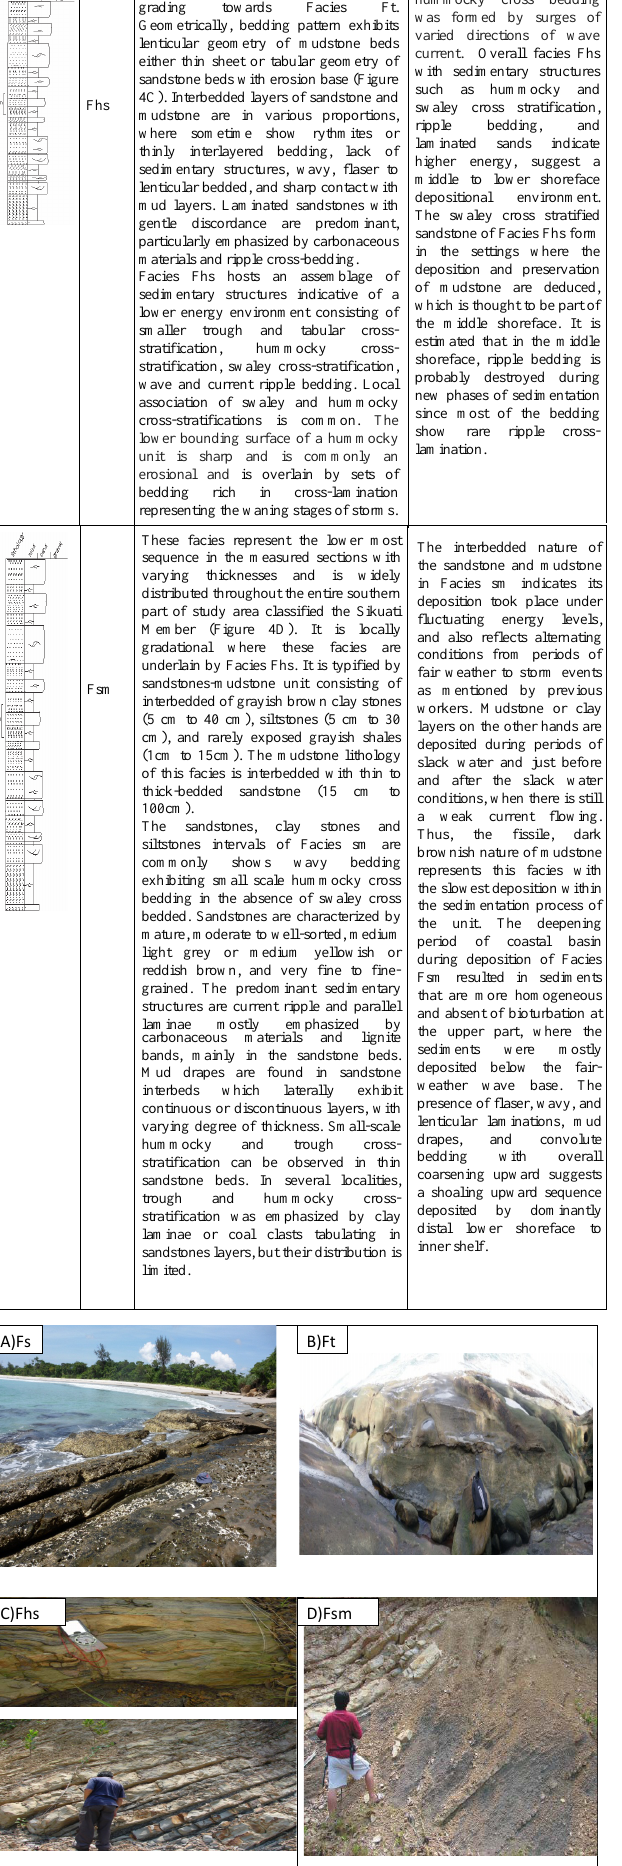
Field outcrops representing facies distribution of the study area; A. Facies Fs: Planar Cross-Bedded Sandstones, B. Facies Ft: Trough Cross-stratified Sandstones, C. Facies Fhs: Hummocky-Swaley Cross-stratified Sandstone and D. Facies Fsm: Association of Interbedded of Thin Sandstones and Mudstone. 5.1 Facies